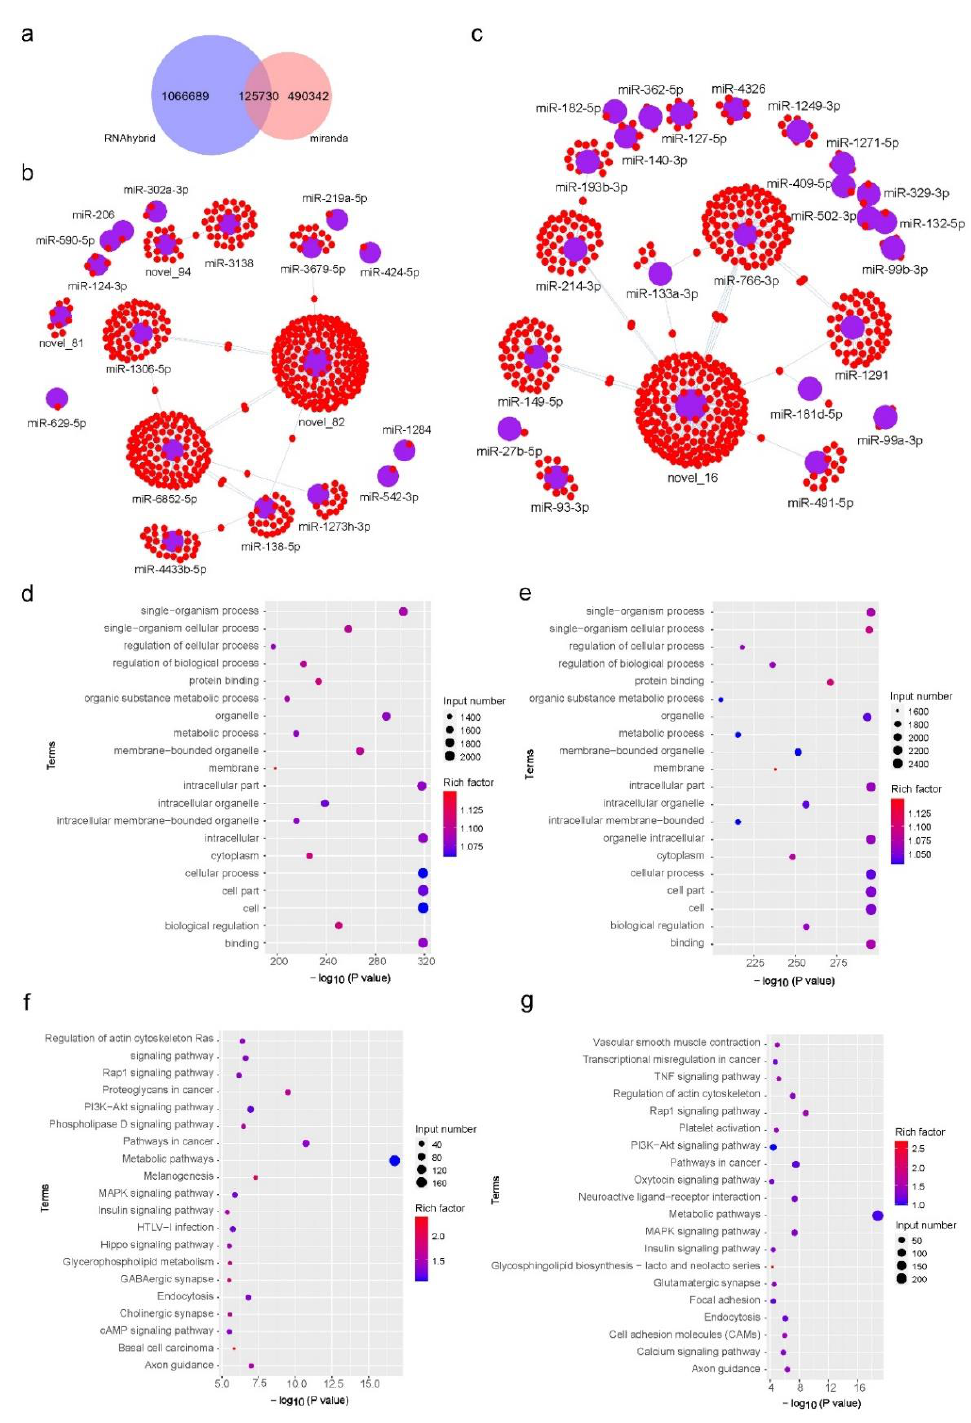
Figure 5. Transcriptome analysis of differentially expressed miRNAs. ( a ) Venn picture of potential target genes by miRanda and RNAhybrid prediction. ( b ) Network of the candidate target genes of upregulated miRNAs. ( c ) Network of the candidate target genes of downregulated miRNAs. The red dots represent candidate target genes, and the blue dots represent miRNAs. ( d ) Enrichment analysis of upregulated expressed genes by GO analysis. ( e ) Enrichment analysis of downregulated expressed genes by GO analysis. ( f ) Enrichment analysis of upregulated expressed genes by KEGG pathway analysis. ( g ) Enrichment analysis of downregulated expressed genes by KEGG pathway analysis.